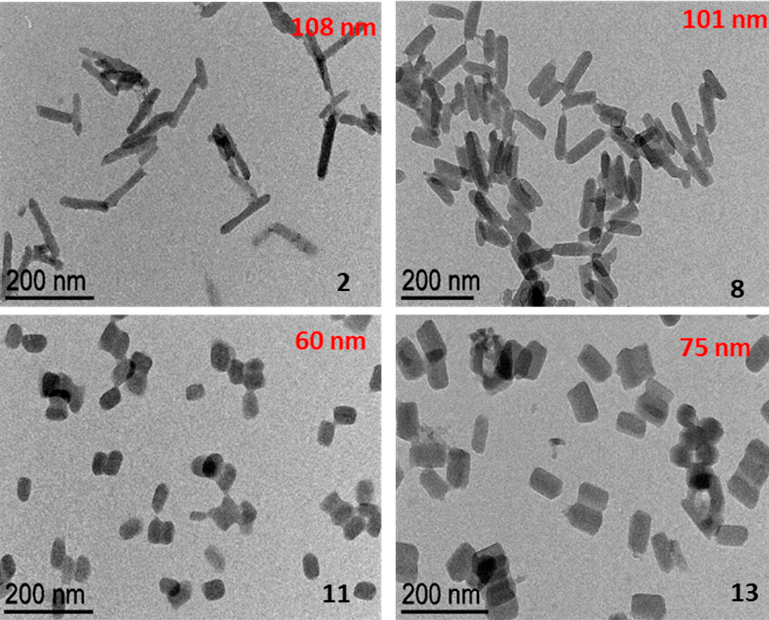
Figure 3. TEM images of the [Fe(Htrz) 2 (trz)](BF 4 )@SiO 2 nanoparticles obtained following the differ-